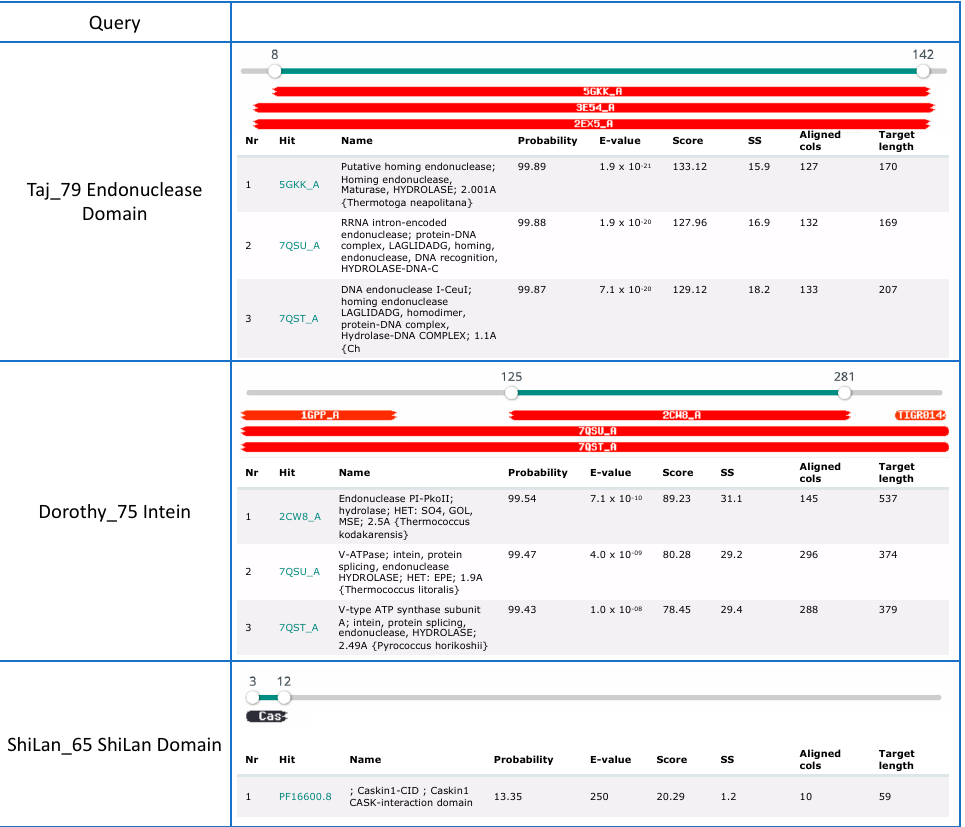
Figure 3. Results from HHPred searches using the three inserted sequences as queries. Only the three most probable matches are given. The endonuclease domain exhibits significant similarity to endonucleases of the LAGLIDADG type. The intein over its whole length matches intein sequences (match two and three). The search with the ShiLan domain did not result in any significant matches.